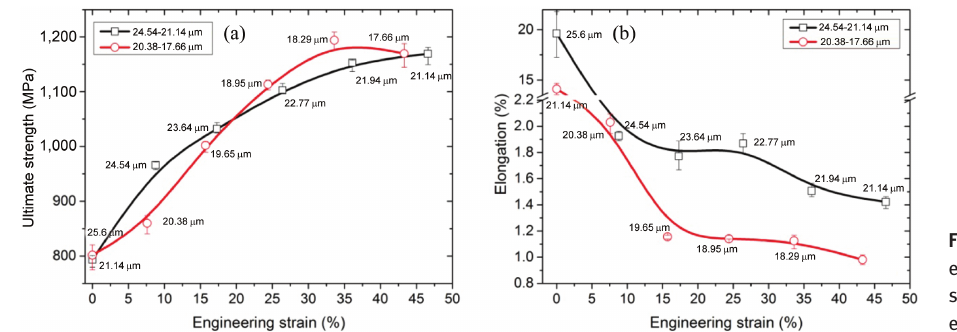
Figure 5: Ultimate strength and elongation of the deformed specimen with different engineering strains.